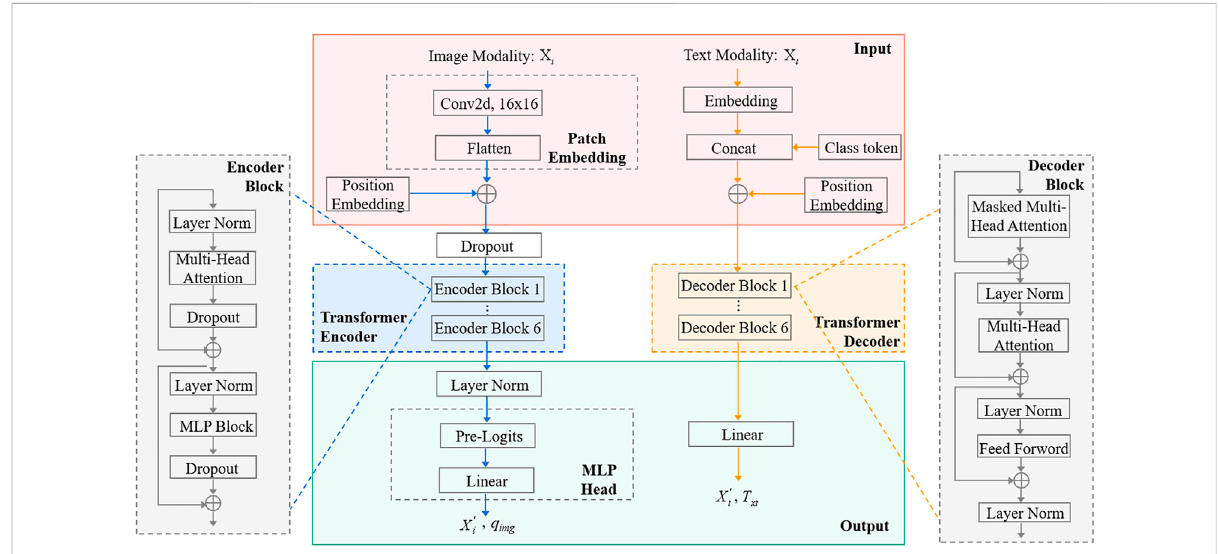
FIGURE 3 CCPViT: Xi and Xt refer to the features of image modality and text modality, respectively. The input image is a 224×224 RGB image. The backbones of the image encoder and unimodal text decoder are shown in the blue and yellow boxes, respectively.